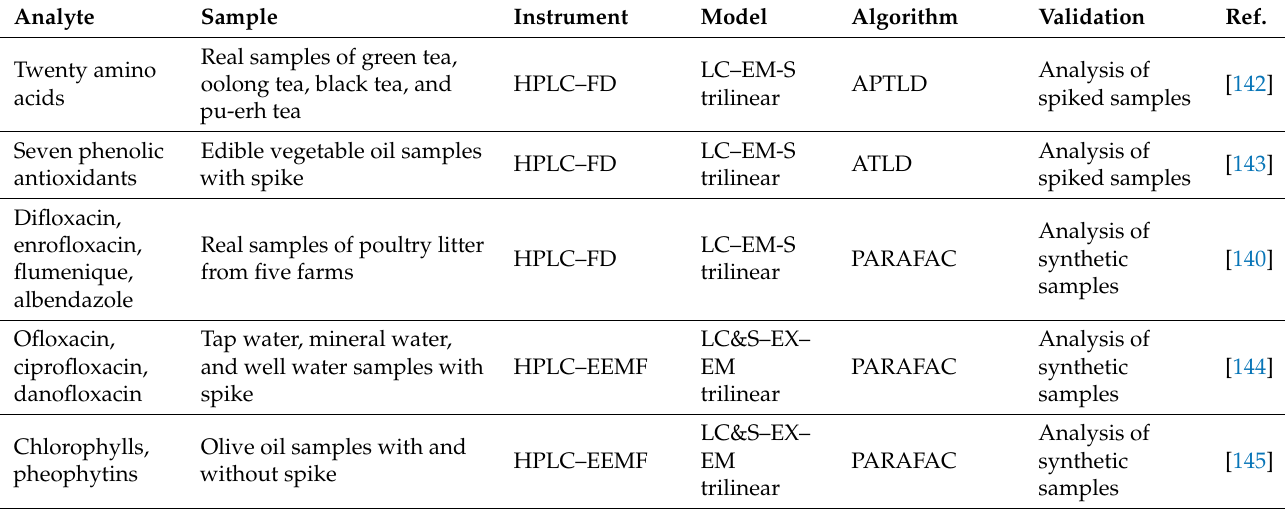
Table 2. Analytical applications of high-performance liquid chromatography–fluorescence detector (HPLC–FD) and high- performance liquid chromatography–excitation-emission matrix fluorescence detector (HPLC–EEMF) assisted by three-way analysis based on the trilinear